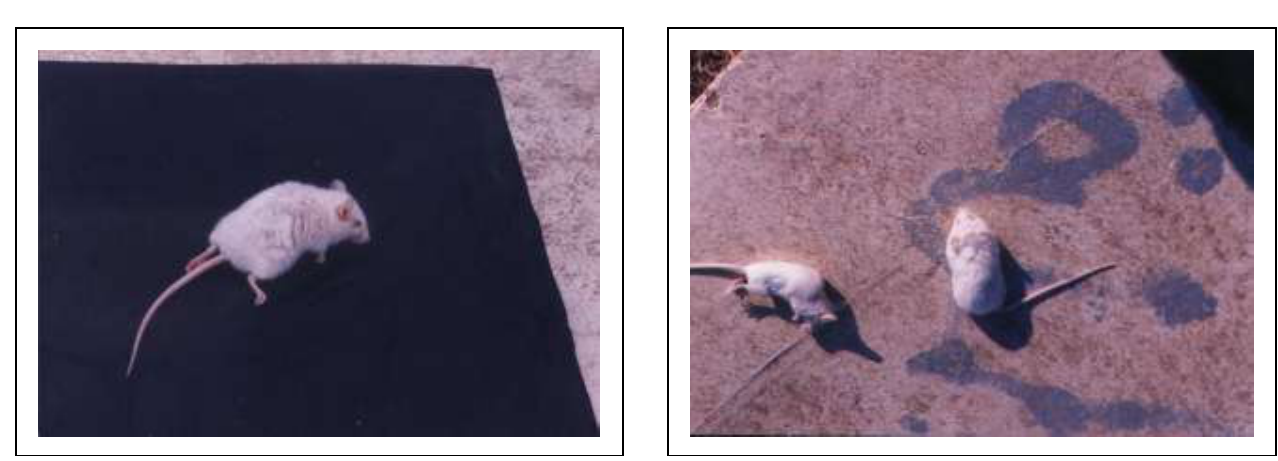
Fig 2 Two mice(from group C)suffering from hypoglycaemic attacks, one showed arch back , while the other showed signs of turning over.